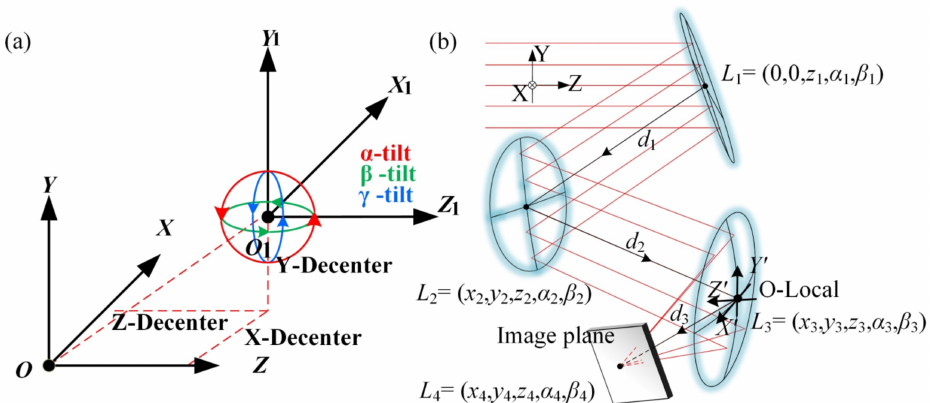
Figure 1. ( a ) Illustration showing definitions of decenters and tilts. The arrow indicates the direction of rotation, and red, green, and blue represent the α , β , and γ tilts, respectively. ( b ) Global coordinate system and local coordinate system of a surface in the nonsymmetric off-axis three-mirror freeform optical system. The vectors L i = ( x i , y i , z i , α i , β i ) ( i = 1,2,3,4) are position parameters of the i th